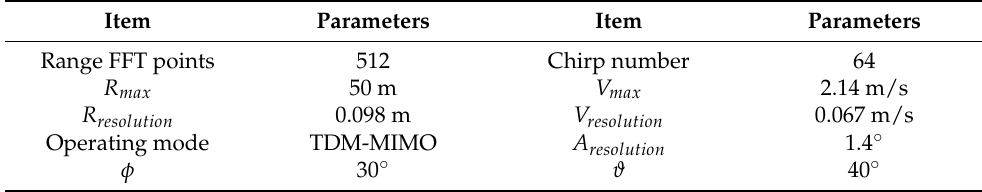
Figure 4. Radar systems. Table 1. Radar platform